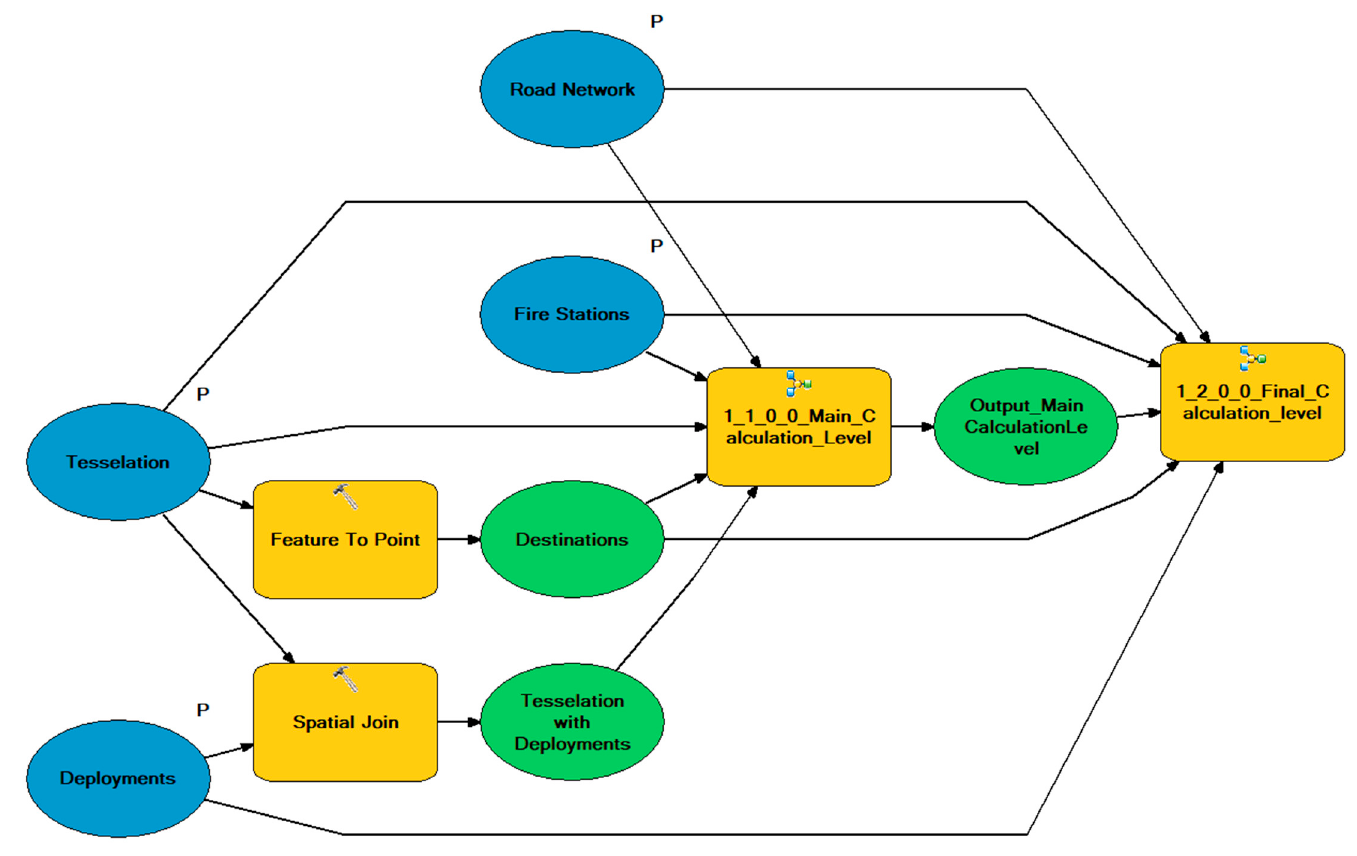
Figure A1. Ground Level (CF_Top) in ArcMap ModelBuilder.